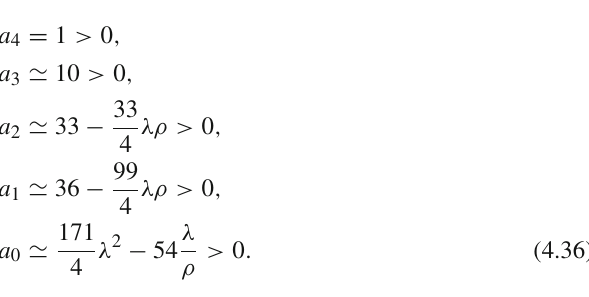
Fig. 1 Attractor property of the anisotropic fixed point with the field parameters chosen as λ = − 0 . 1 and ρ = 50. This plot clearly shows that trajectories with different colors corresponding to initial conditions all converge to the anisotropic fixed point (the black point)